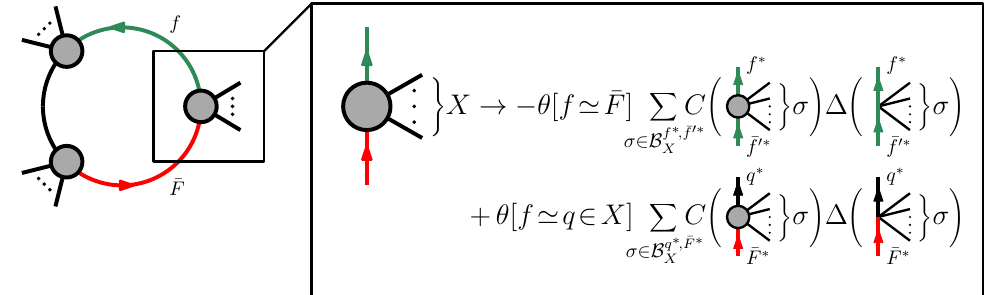
Figure 6 . Inserting a quark-quark stretch tree basis into coloured cuts of a one-loop amplitude. The (cid:18) functions are non-zero when the two (cid:13)avours are the same. The (cid:12)rst term is present if the stretched quarks are of the same (cid:13)avour. The second term is present if the stretched (cid:13)avour is also in the set of external